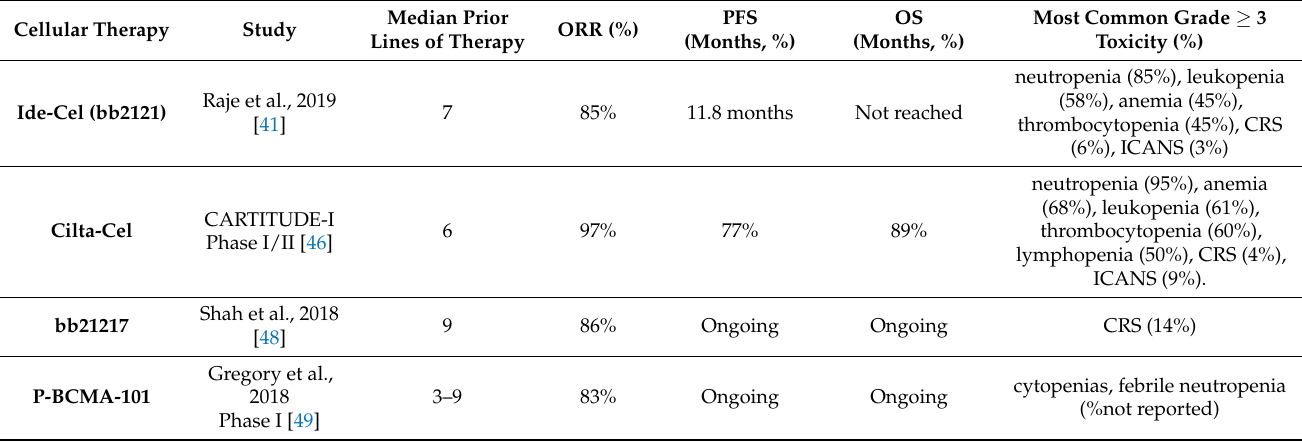
Table 3. Cellular therapy clinical trial results in relapsed or refractory multiple